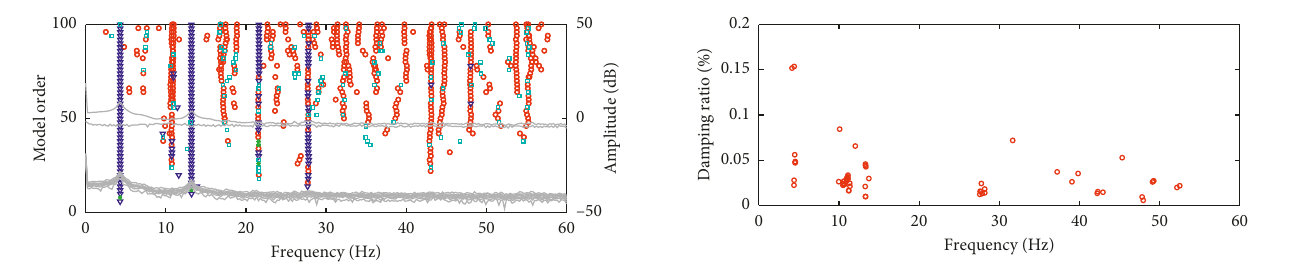
Figure 10: Stabilization diagram (H2).